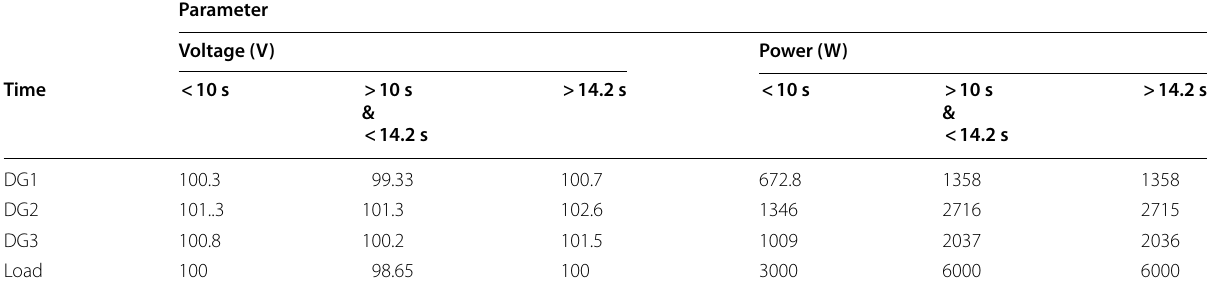
Table 4 System data primary and secondary control approach without communication